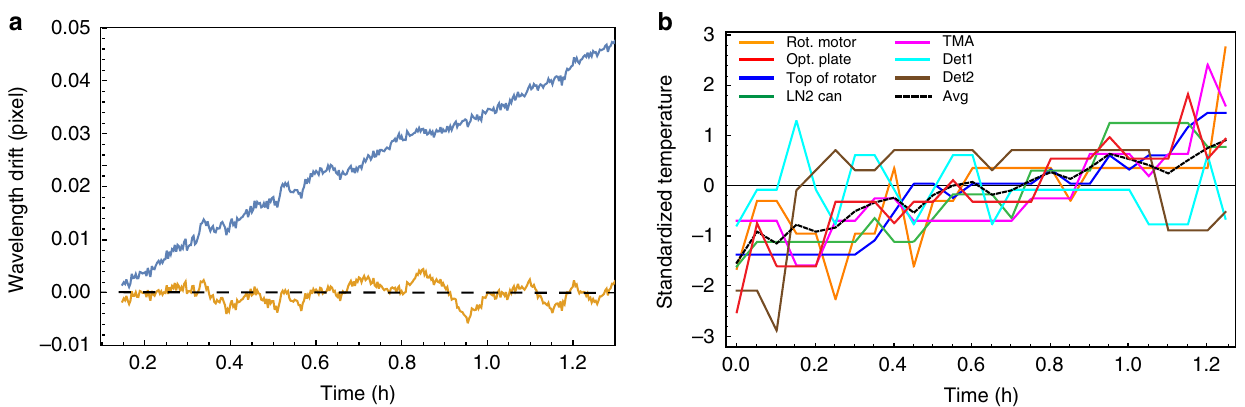
Figure 6 | Measurement of wavelength and temperature drift on the Keck II NIRSPEC spectrometer. ( a ) The blue curve shows the drift in the pixel location of individual comb lines in order 48 as measured with the cross-correlation techniques described in the text. The yellow curve shows the residual shifts after de-correlating the effects of the internal NIRSPEC temperatures. ( b ) Five internal NIRSPEC temperatures are shown as a function of time. For ease of plotting, the individual temperatures have been standardized with respect to the means and s.d. of each sensor (Table 1). The black dashed curve shows the average of these standardized temperatures. The effect of the quantization of the temperature data at the 10mK level (as recorded in the available telemetry) is evident in the individual temperature curves.